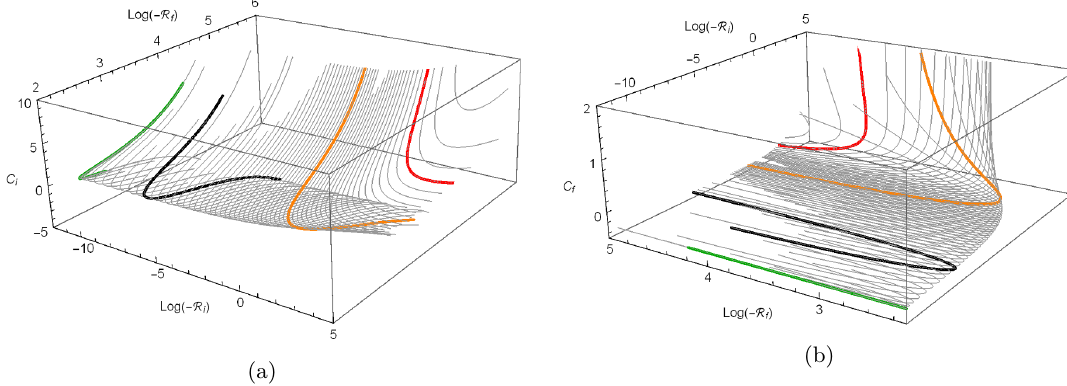
Figure 27 . As we change S 0 along a ϕ 0 = constant line in the blue region in figure 25b we can read C i and C f in terms of the dimensionless curvatures. For example in above figures, the red curve is at ϕ = 1 , the orange curve at ϕ 0 10